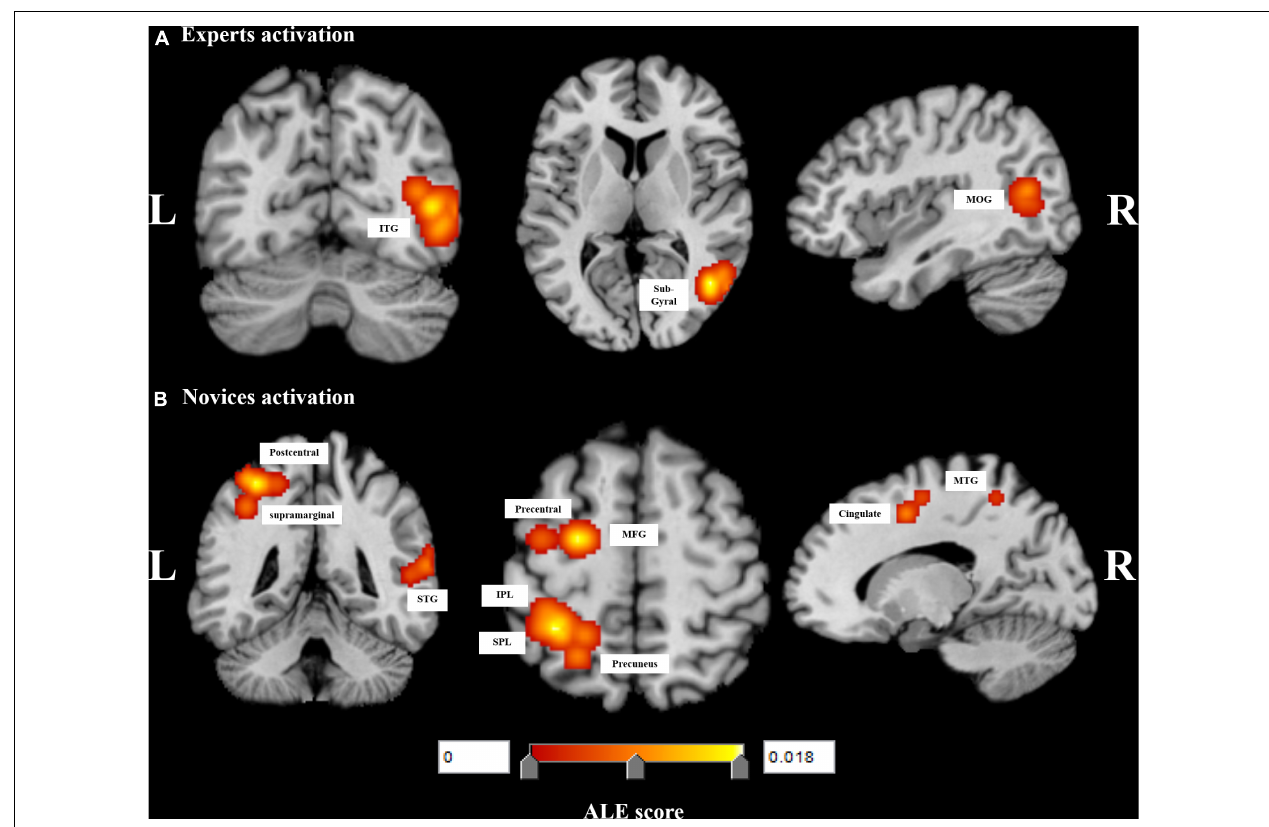
FIGURE 2 | Significant meta-analysis results for (A) experts and (B) novices performing decision-making tasks. L, left, R, right, inferior temporal gyrus, ITG, middle occipital gyrus, MOG, superior parietal lobule, SPL, inferior parietal lobule, IPL, middle frontal gyrus, MFG, middle temporal gyrus, MTG.